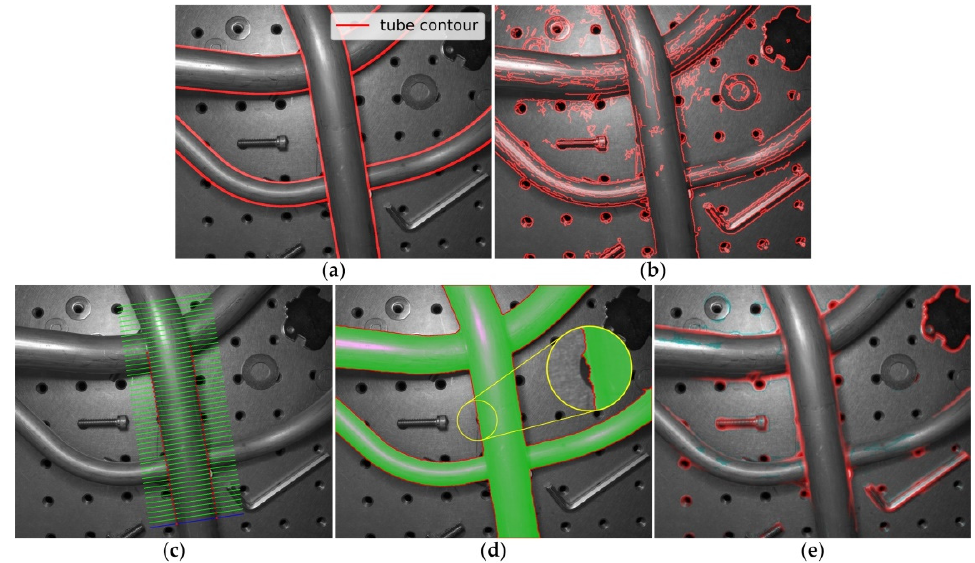
Figure 1. Tube contours detected by different methods. ( a ) Ground truth; ( b ) Canny [4]; ( c ) Aubry [8]; ( d ) U-Net [12]; and ( e ) HED